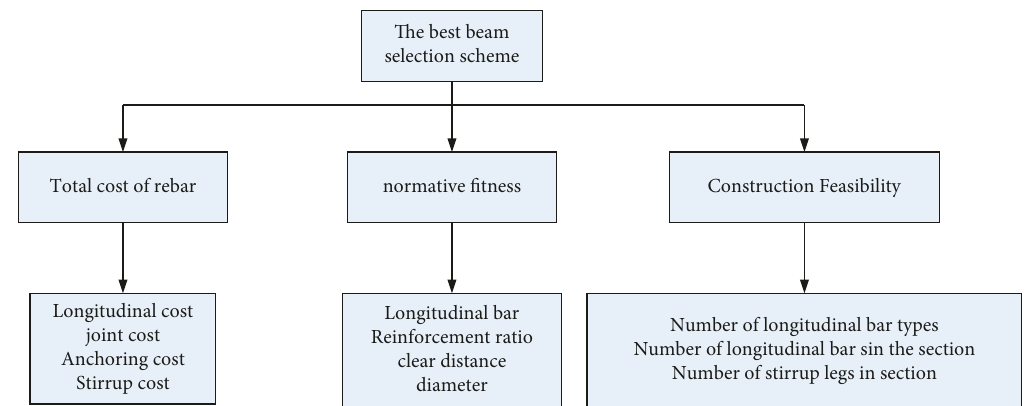
Figure 4: Target evaluation system for beam selection.